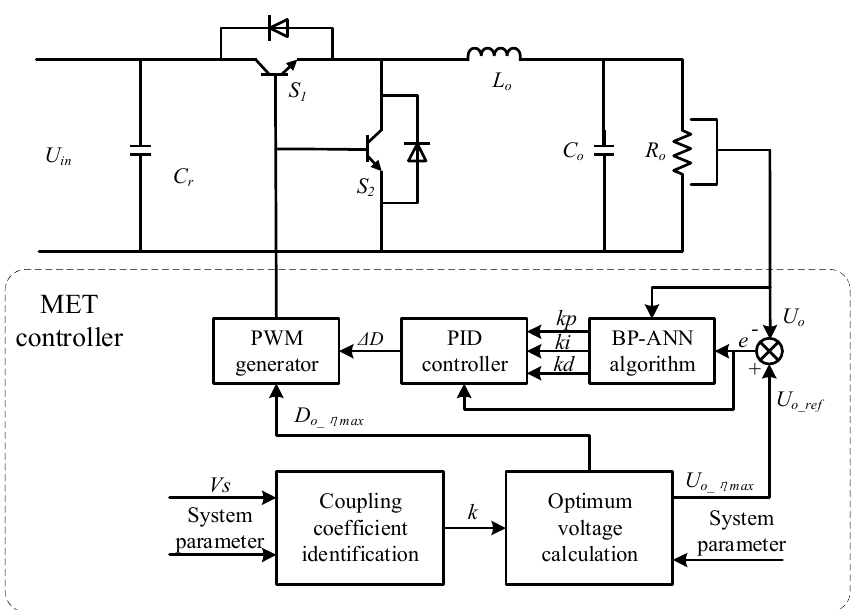
Figure 9. Block diagram of buck converter with the proposed control system.